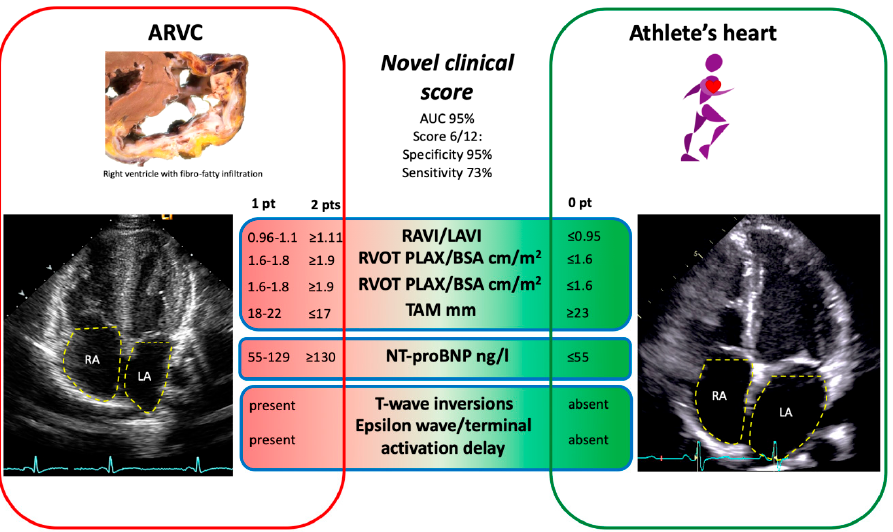
Figure 2. Novel score to differentiate the Athlete’s Heart from ARVC.